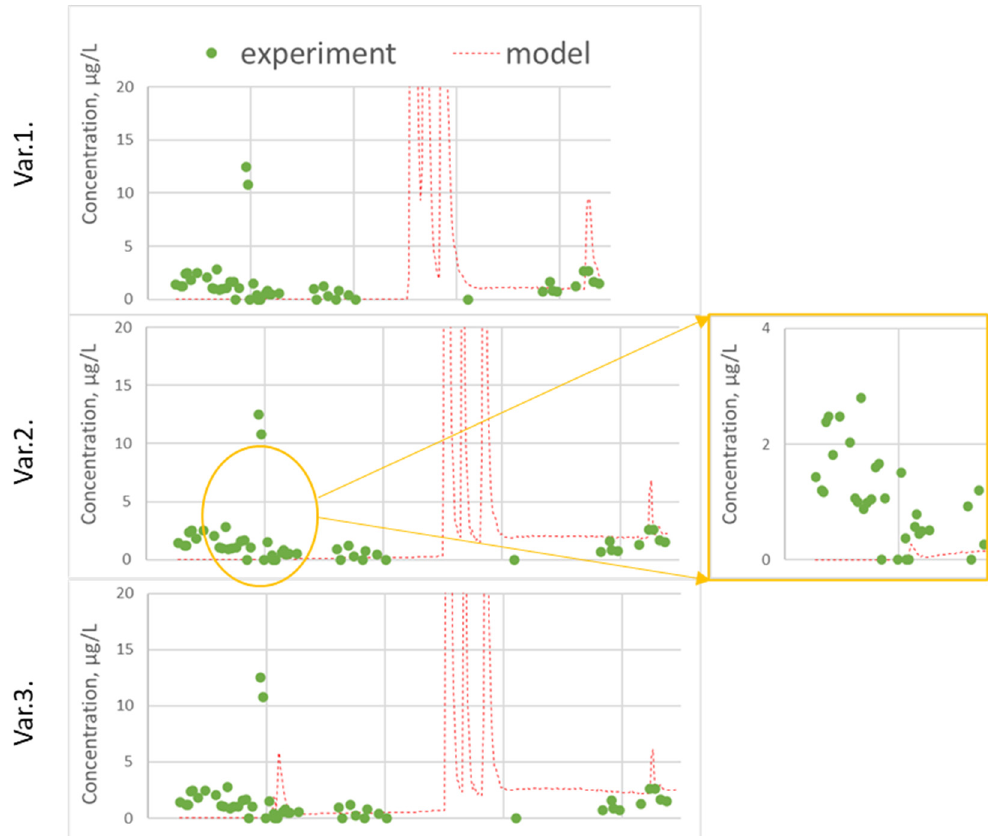
Figure 6. Measured and predicted cyantraniliprole concentration in leachate: (var. 1) without calibration; (var. 2) DT50 and DV calibration; (var. 3) variant 2 + ASCALE, DT50 and K oc in deep horizons.